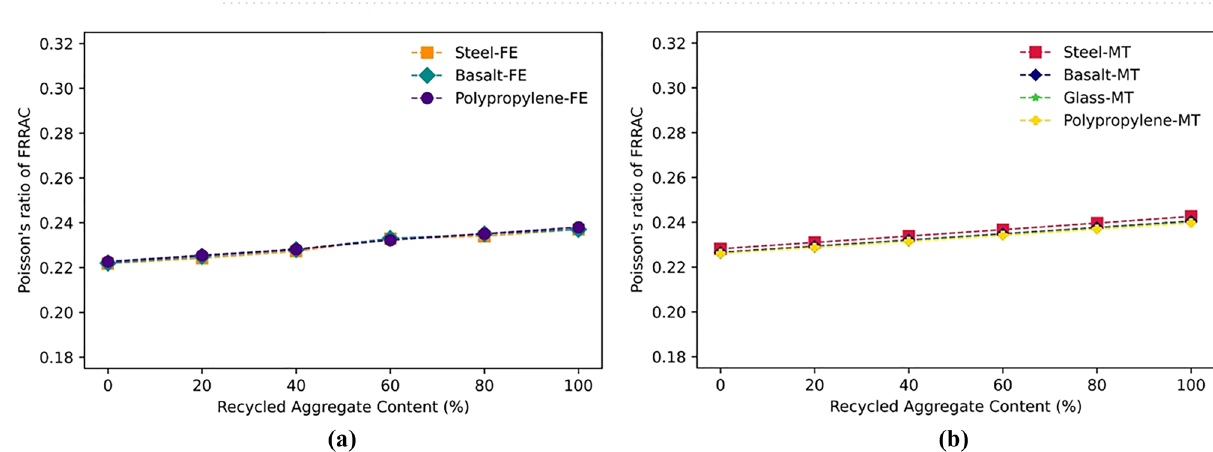
Figure 13. The elastic modulus of FRRAC based on RA content: ( a ) FE approach, ( b ) MT approach.